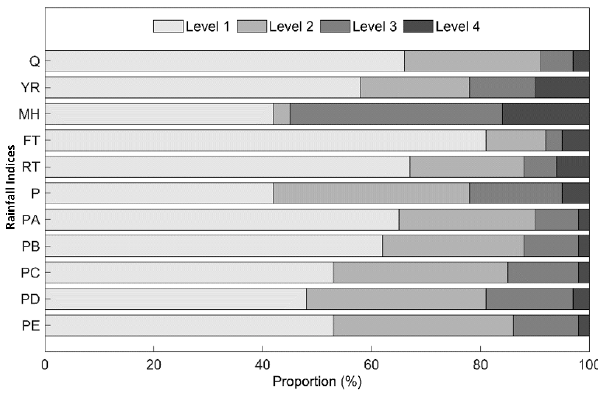
Figure 3. Proportion of the four levels in the rainfall indices.